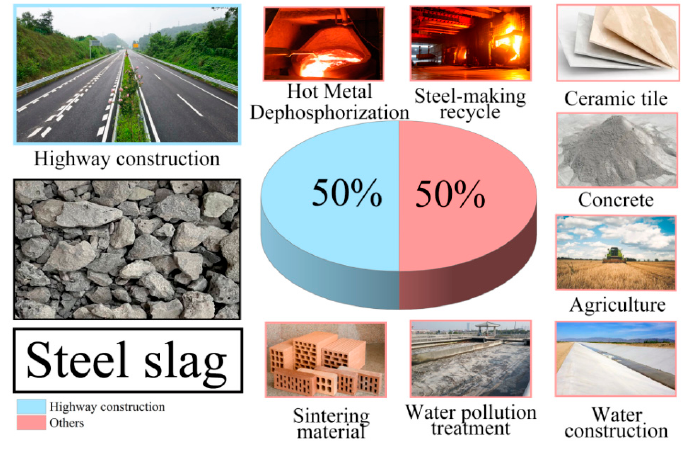
Figure 1. The main uses of SL.